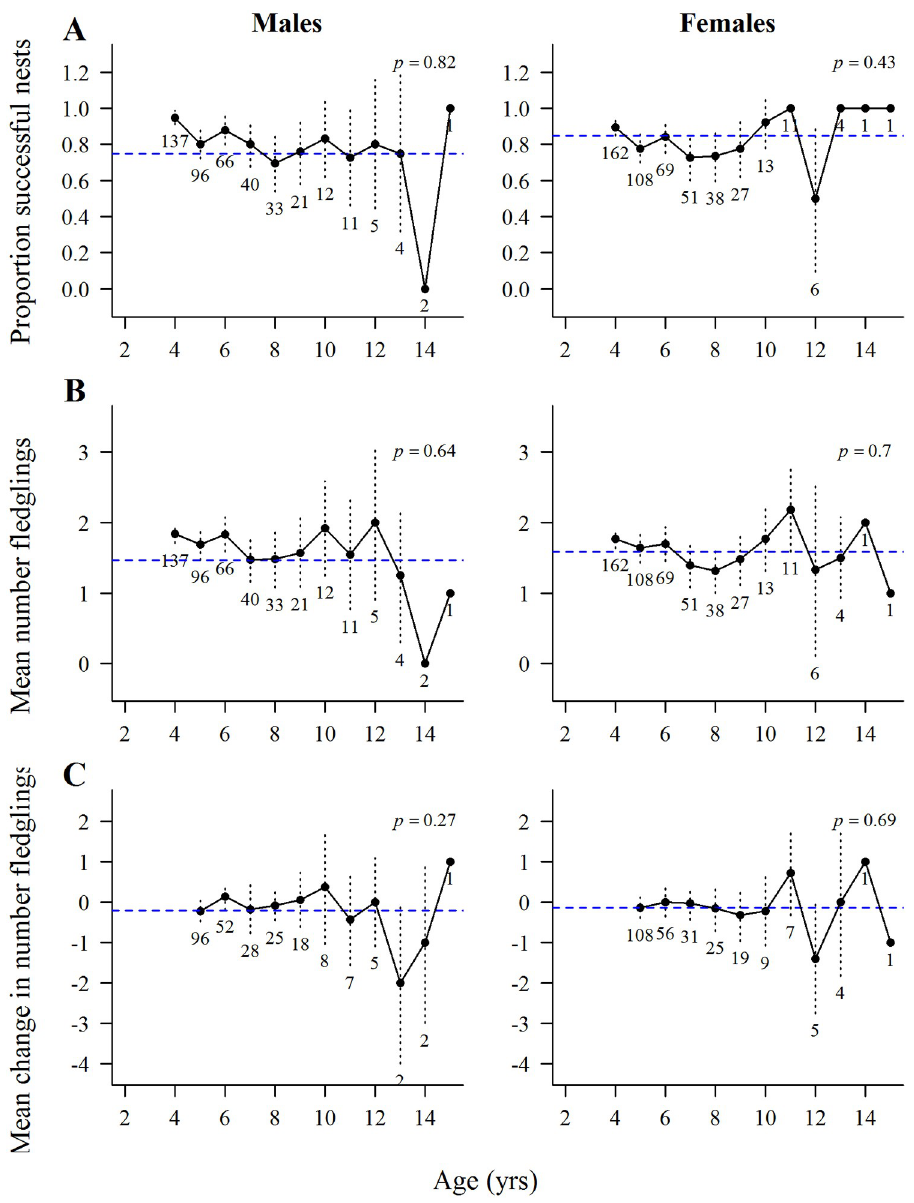
Fig 6. Age-specific reproduction by goshawks aged � 4-years-old at first breeding. Means, ± 2 standard errors, and overall mean values (horizontal dashed line) of raw data from the GAMM analyses of age-specific reproduction by male and female northern goshawks assigned a minimum age of � 4-years old at their first breeding attempt in Arizona, USA. Numbers below standard error bars indicate the number of males and females in each age group. (A) nest success (fledged � 1 young) as a function of age in 428 breeding attempts by 137 males and 491 attempts by 162 females, (B) fledgling production as a function of age in 428 attempts by 137 males and 491 attempts by 162 females (population-level analyses), and (C) changes in numbers of fledglings produced in 244 attempts by 107 individual males and in 266 attempts by 119 females that bred in one and the next year (individual-level analyses). 58 males ( P = 0.64) or by 88 females ( P = 0.70) in 491 attempts (Fig 5B). Likewise, among the � 4-year-old hawks, there were no significant age effects in 428 breeding attempts by 137 males ( P = 0.25) or 162 females ( P = 0.46) in 491 attempts (Fig 6B). There were no significant year effects on males ( P = 0.66) or females ( P = 0.24) of known-age, but year effects were